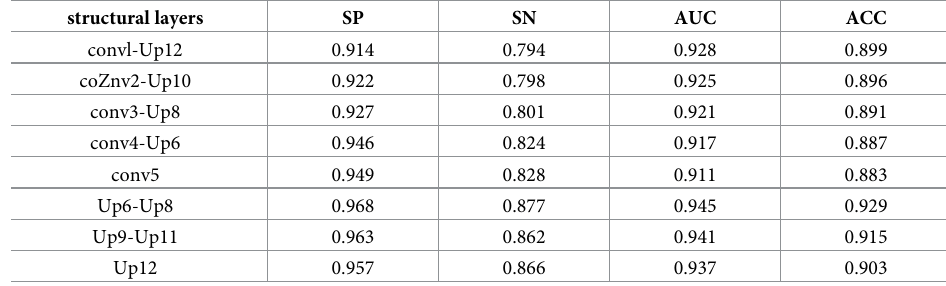
Table 10. Experimental results of fine-tuned network parameters of different layers. structural